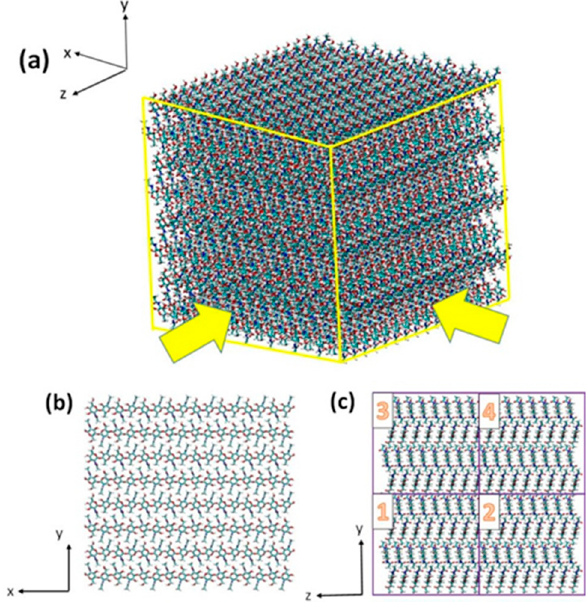
Figure 6 . ( a ) The 3D view of the complete chitin model; ( b , c ) Two cross sectional views of chitin model ( c ) also shows the model numbering system. Numbers 1–4 correspond to the four regions divided to make atom-selection easier for later SMD simulation work.